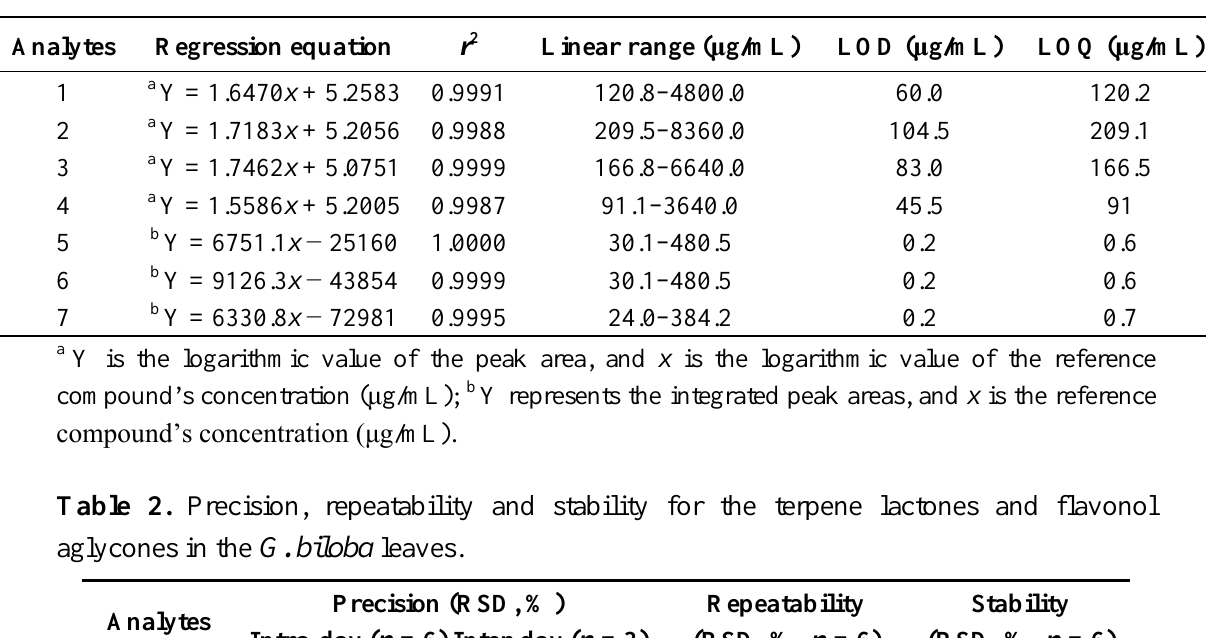
Table 1. Regression equation, correlation coefficients, linearity ranges, limits of detection (LOD) and limits of quantification (LOQ) of investigated compounds by HPLC-ELSD and HPLC-PDA.